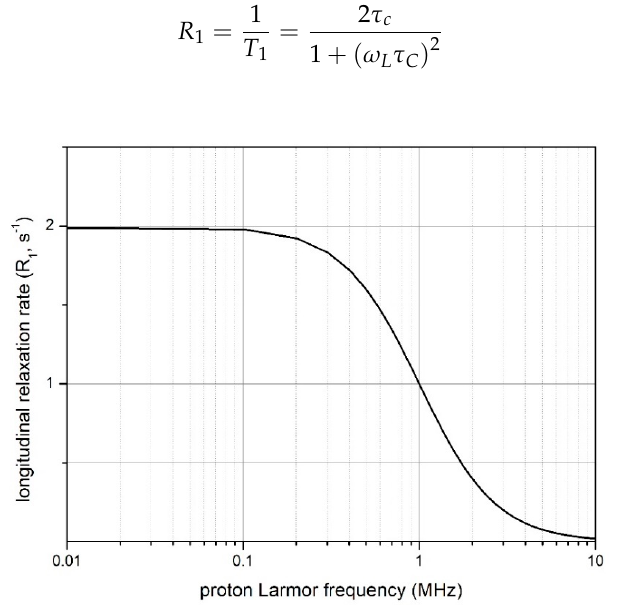
Figure 6. Representation of the three different motions of H 2 O molecules in quartz sand as inferred by the results of the relaxograms reported in Figure 5. A . Horizontal surface diffusion. B . Interparticle